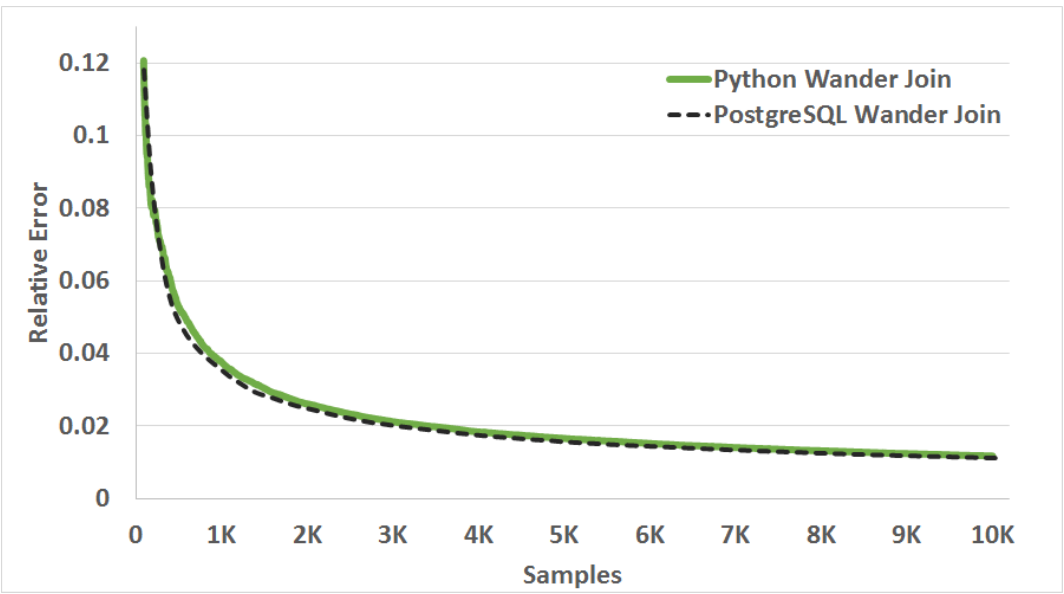
Figure 2. The relative error at 95% confidence level for our Python implementation of Wander Join and the original PostgreSQL implementation of Wander Join for 1 to 10,000 samples. Our reimplementation of the algorithm converges at the same rate as original Wander Join for a JOIN query with no filtering or GROUP BY in the